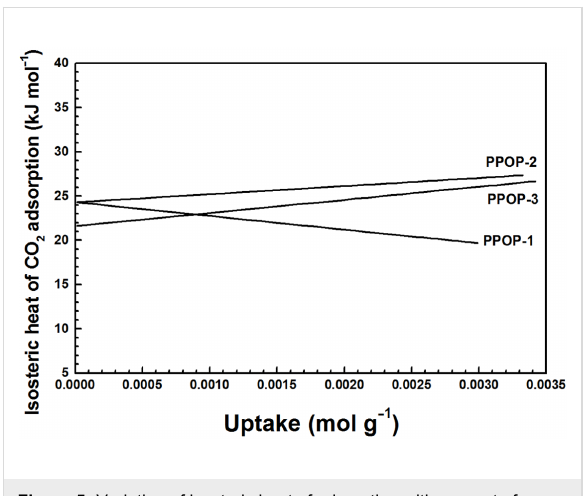
Figure 5: Variation of isosteric heat of adsorption with amount of adsorbed CO 2 in PPOP-1 , PPOP-2 , and PPOP-3